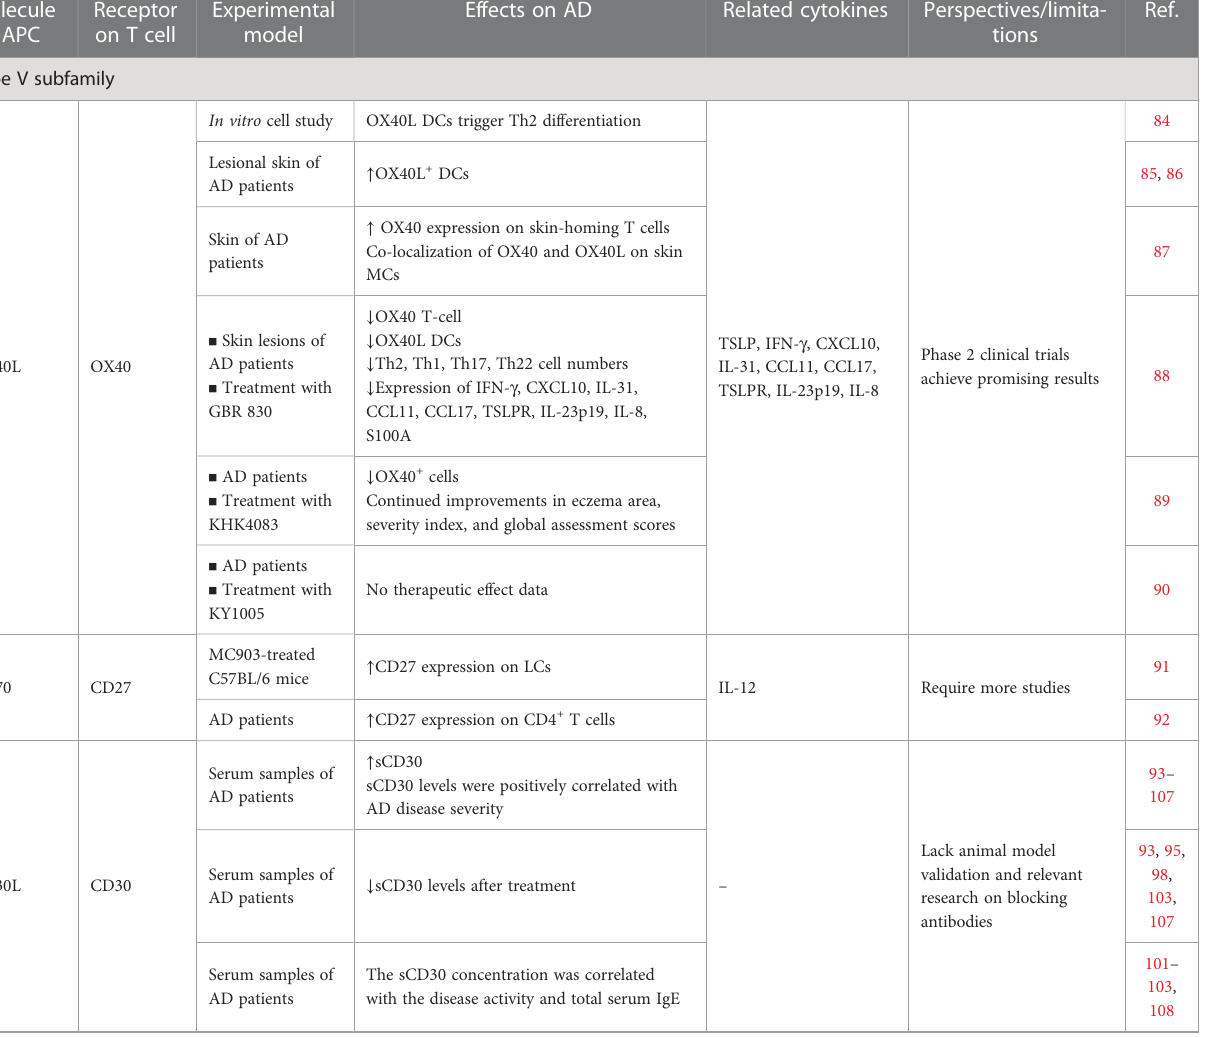
Perspectives/limita- tions